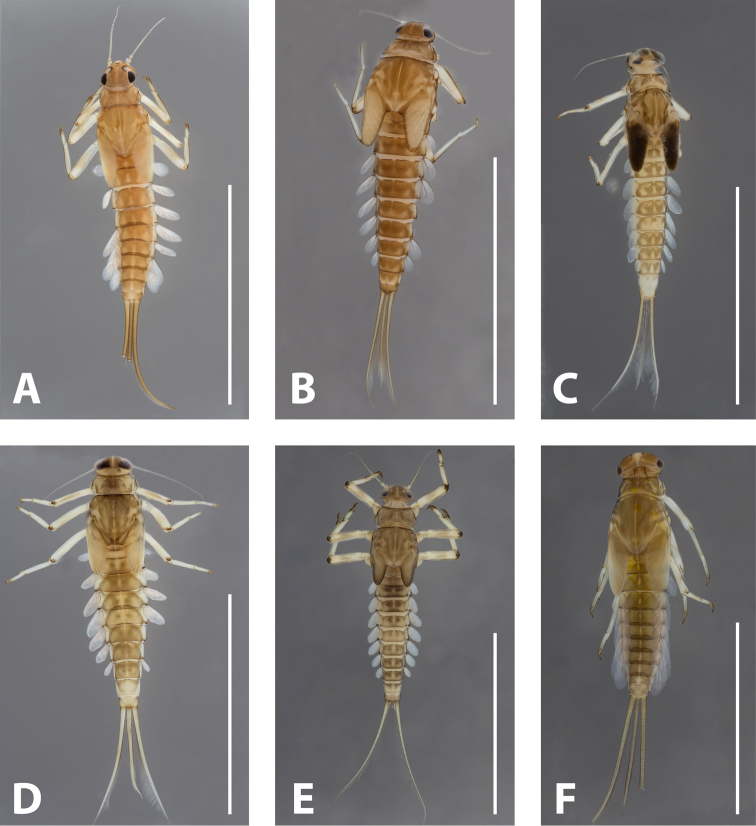
Nymphs of Israeli Baetis species, habitus. ABaetisaureus sp. n. BBaetisgolanensis sp. n. CBaetismonneratiDBaetisnoa sp. n. EBaetispacis sp. n. FBaetissamochai. Scale bars: 5 mm.